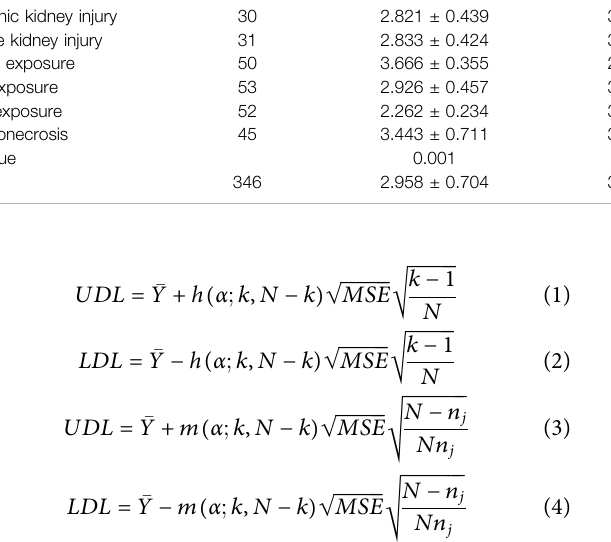
TABLE 1 | Descriptive statistics for MDA, SOD, CAT and GSH levels. Prostate